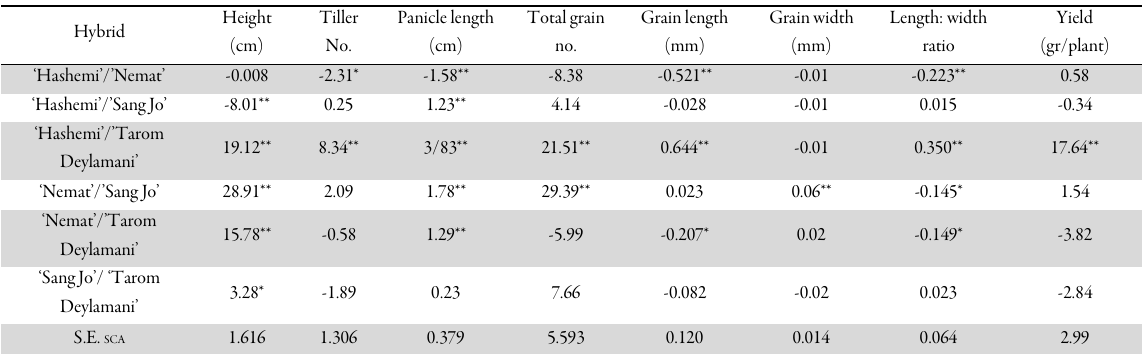
Table 5. Estimation of SCA effects for studied traits Hybrid